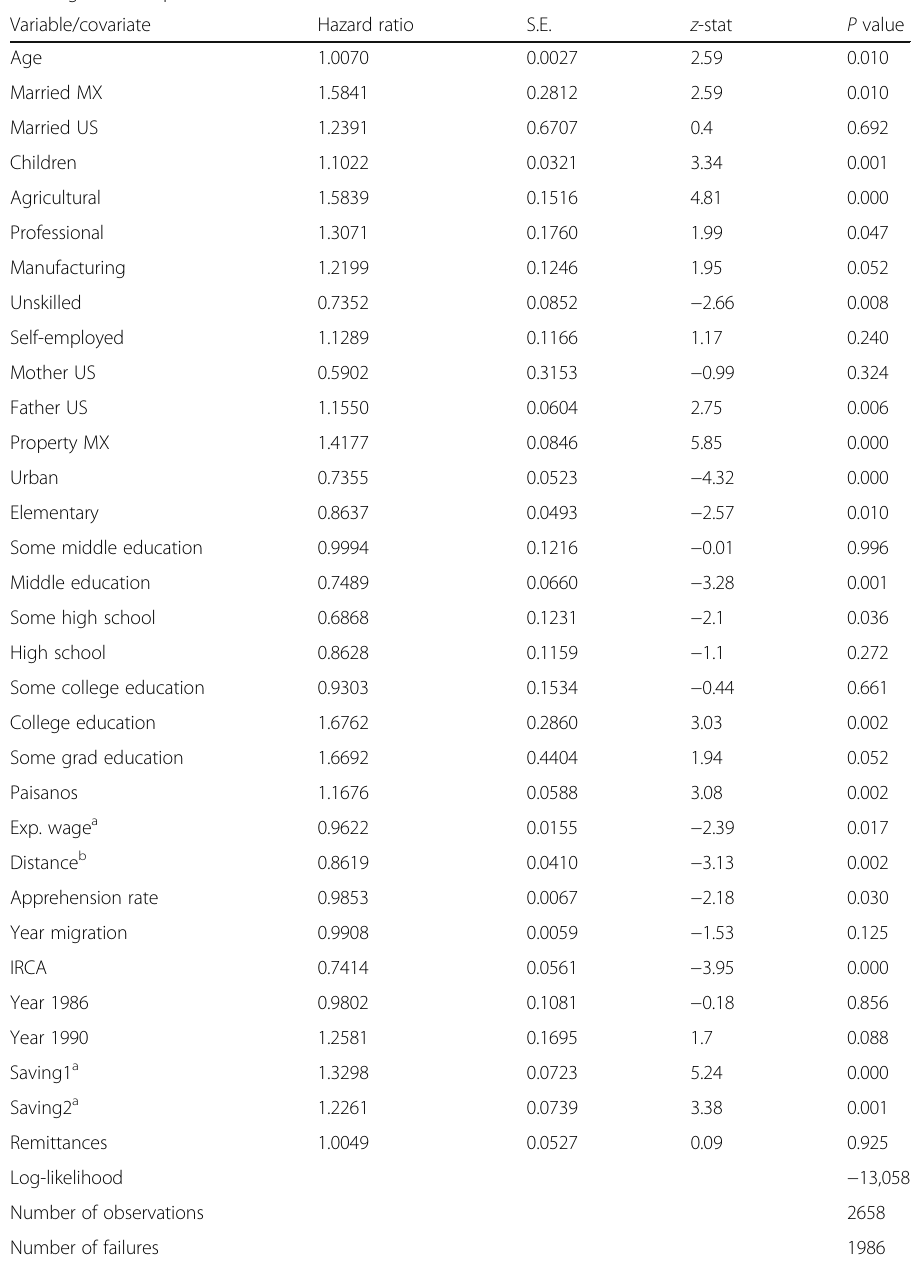
Table 6 Estimates of the determinants of the hazard of returning to Mexico for the last migration